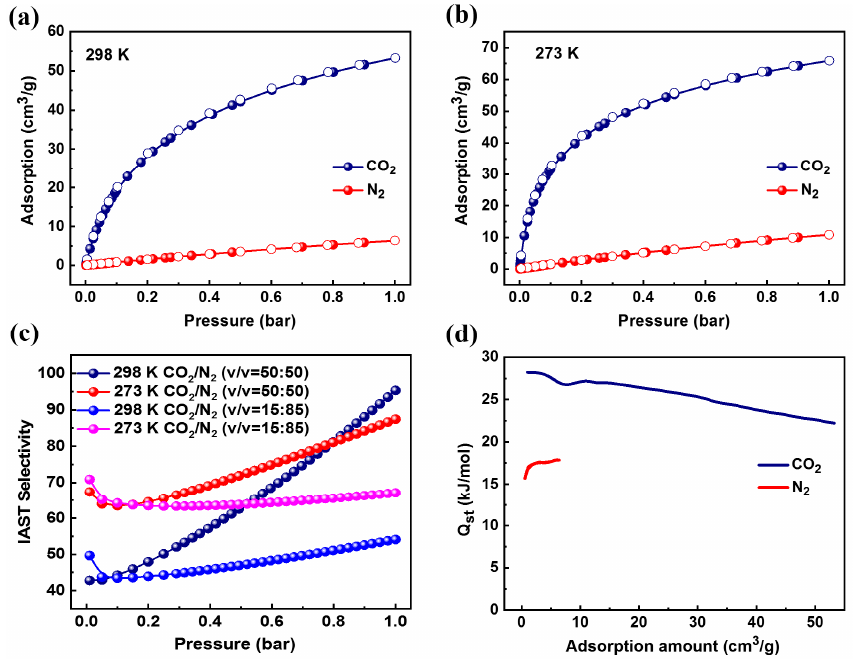
Figure 2. ( a ) The adsorption isotherms of CO 2 and N 2 at 298 K and 1 bar. ( b ) The adsorption iso- therms of CO 2 and N 2 at 273 K and 1 bar. ( c ) The calculated CO 2 /N 2 selectivity at 273 and 298 K. ( d ) The isosteric heats of adsorption ( Q st ) for ZIF-94.